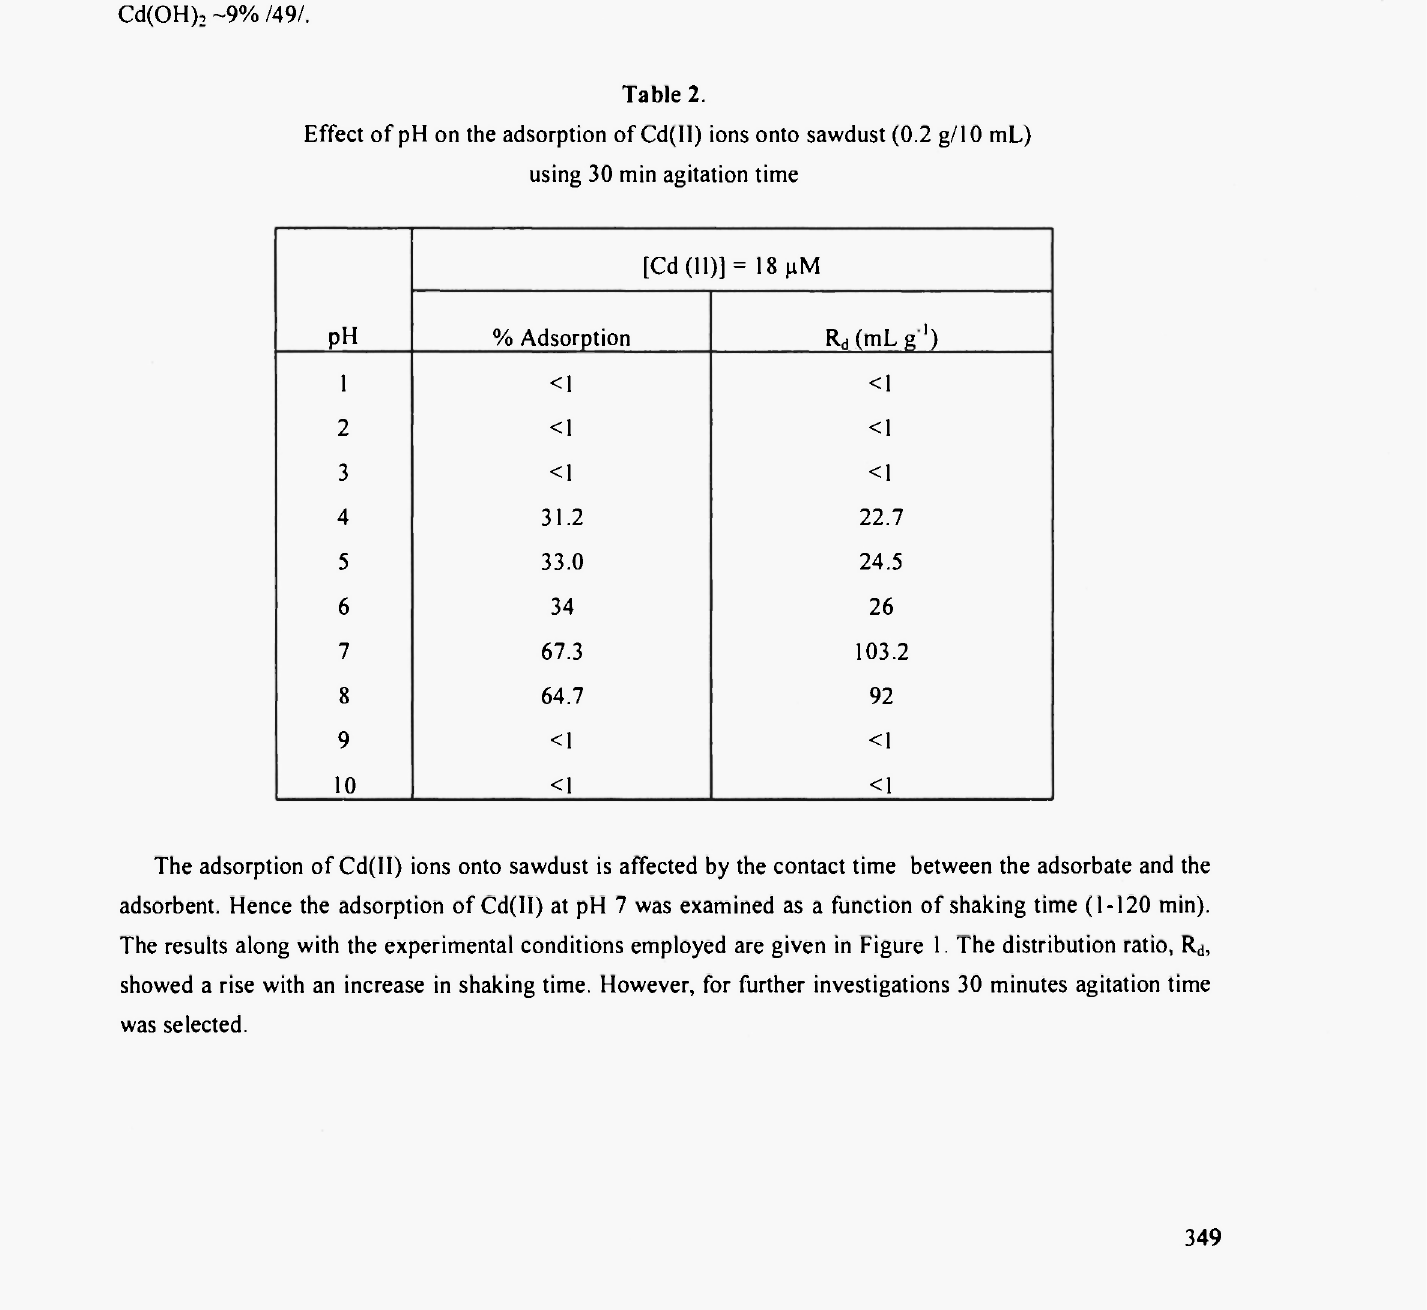
Effect of pH on the adsorption of Cd(II) ions onto sawdust (0.2 g/10